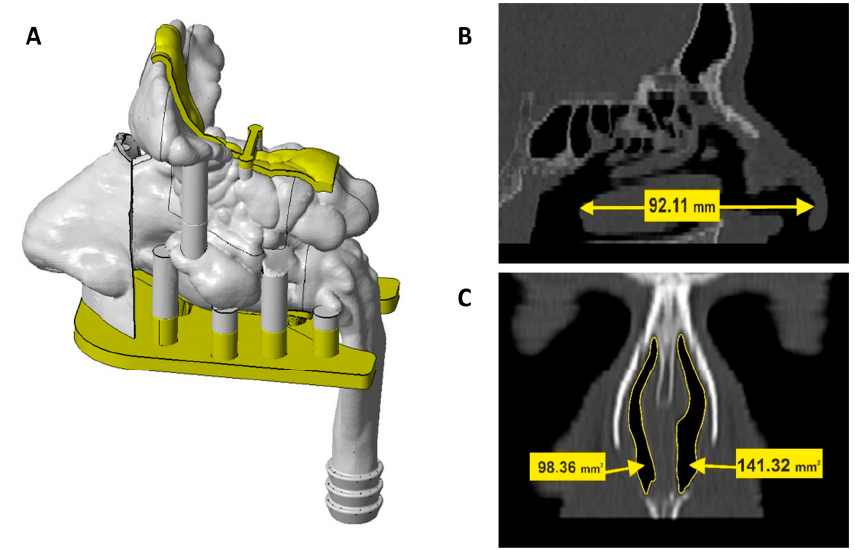
Figure 10. Schematic presentation of a 3D-printed nasal cavity model ( A ) and nasal geometry measurements including length of a nasal cavity (92.11 mm; ( B ) and smallest vertical cross-sectional areas (left: 98.36 mm 2 /right 141.32 mm 2 ; ( C ).